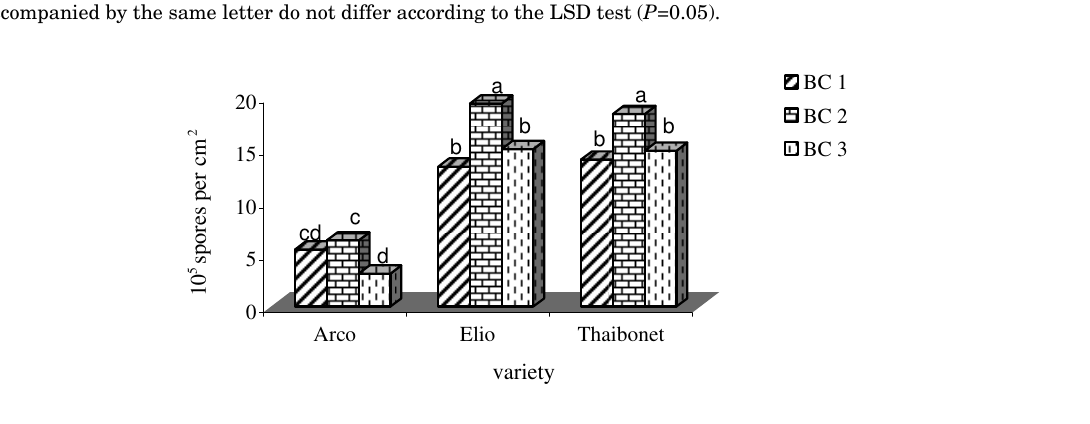
Fig. 3. Sporulation of the strains of Bipolaris cynodontis assessed as number of spores per cm 2 of diseased leaves seven days after inoculation on three rice varieties. Results accompanied by the same letter do not differ according to the LSD test ( P